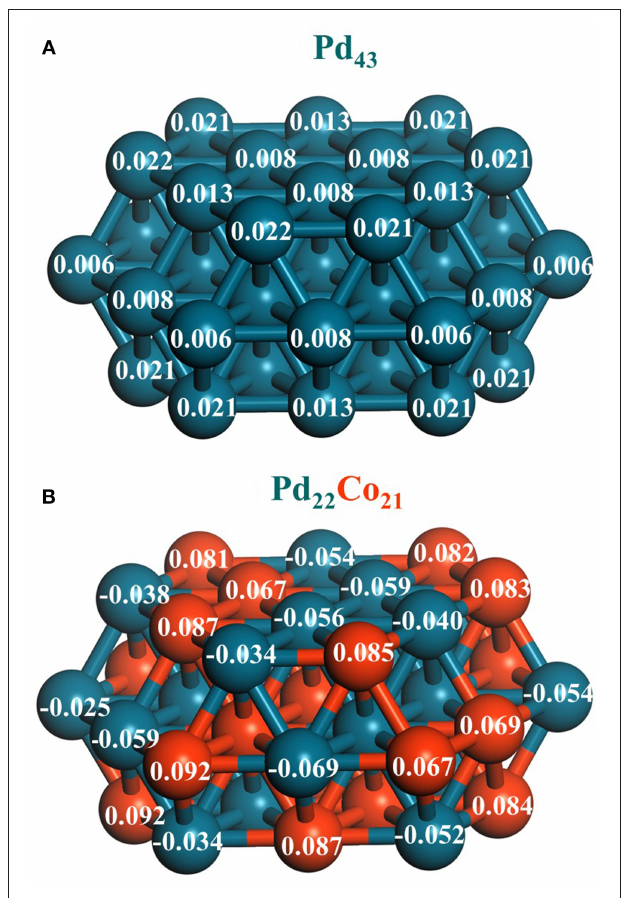
FIGURE 10 | Mulliken atomic charges of (A) monometallic cluster (Pd 43 ) and (B) bimetallic (Pd 22 Co 21 ) cluster. Adapted with permission from Navlani-García et al. (2018b). Copyright 2018